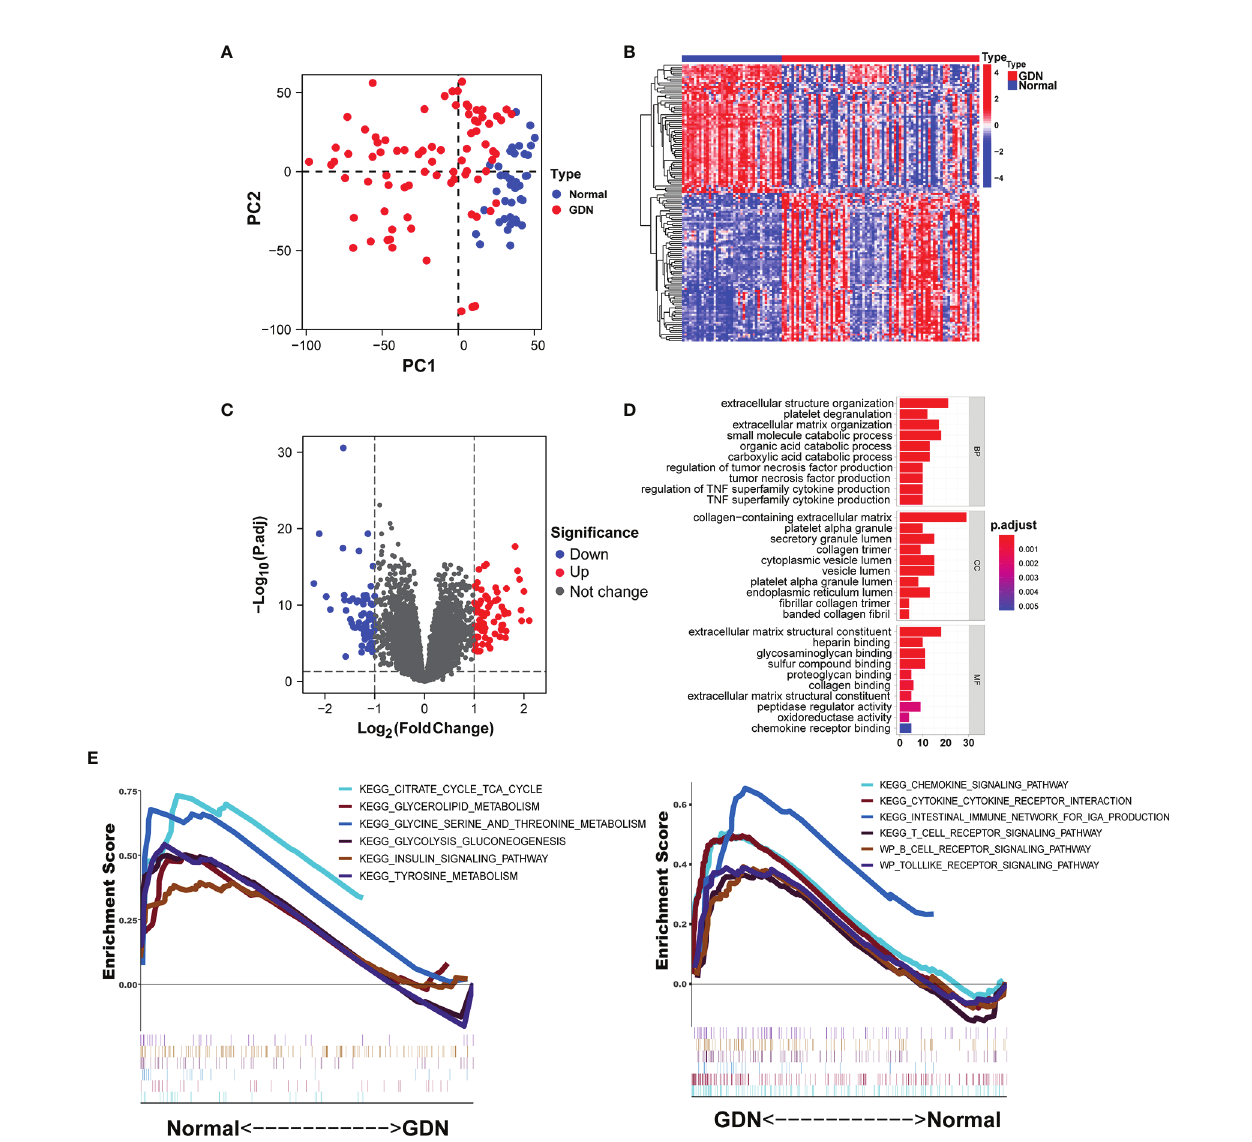
FIGURE 1 | Identi fi cation of DEGs in the GDN training cohort. (A) The principal component analysis (PCA) for the samples. (B, C) Heatmap and the Volcano plot of the DEGs. (D, E) Six enriched signaling pathways in normal or DN